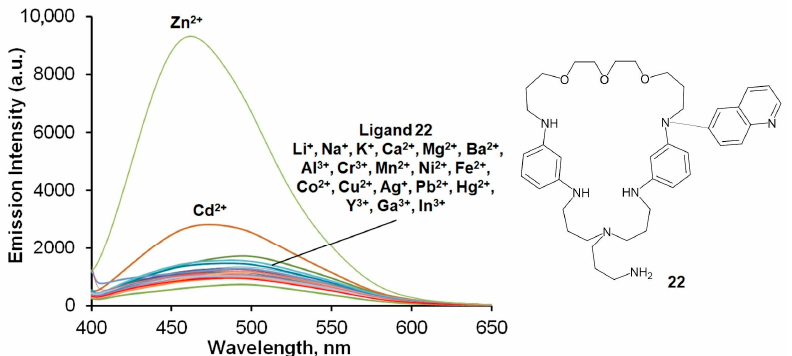
Figure 4. Spectra of the fluorescence of compound 22 in the presence of Li(I), Na(I), K(I), Mg(II), Ca(II), Ba(II), Al(III), Cr(III), Mn(II), Fe(II), Co(II), Ni(II), Cu(II), Zn(II), Cd(II), Hg(II), Pb(II), Ag(I), Ga(III), In(III) and Y(III) (five equiv.). C L 14.3 μ M, λ ex 370 nm.